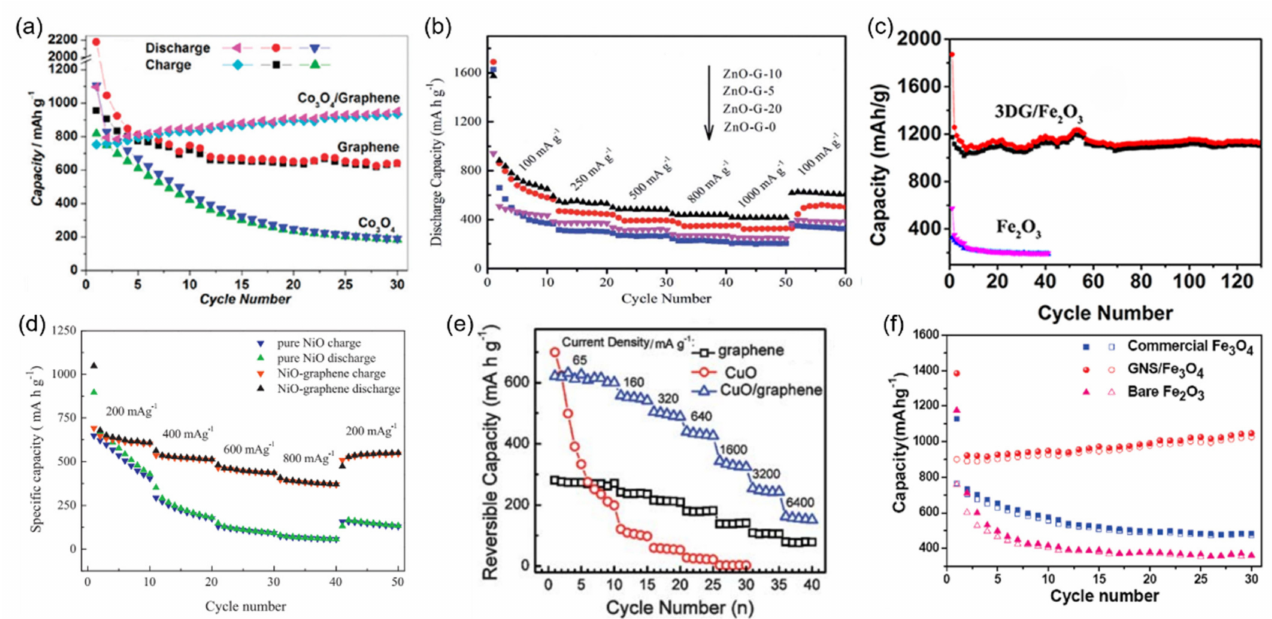
Figure 7. Cycle performance of graphene composite anode materials with ( a ) Co 3 O4, ( b ) ZnO, ( c ) Fe 2 O 3 , ( d ) NiO, ( e ) CuO, and ( f ) Fe 3 O 4 . Reproduced with permission from ref. [71–73,75,76,80], respectively. Copyright 2010, ACS